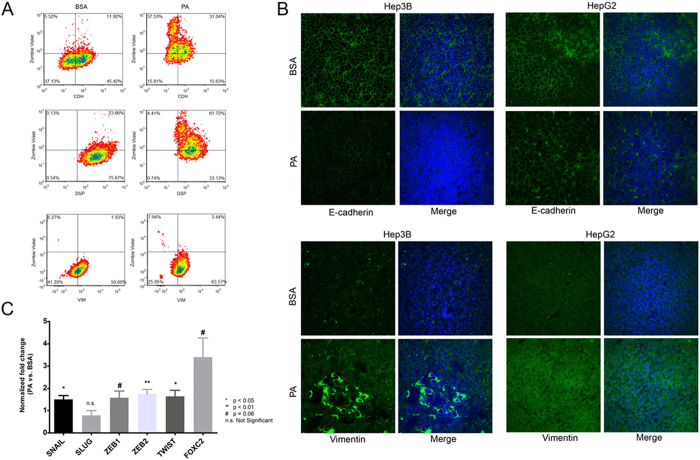
Population effect of PA on EMT marker expression.(A) Density plots showing distribution of cells co-stained with zombie violet (Y-axis) and either CDH, DSP or VIM (X-axis) in HepG2 cells treated with BSA or PA (0.3 mM). The bars represent staining thresholds for zombie violet (horizontal bar) or the protein markers (vertical bar). Lower left quadrant represents background staining, upper left quadrant represents cells stained with only zombie violet, upper right quadrant represent cells co-stained with zombie violet and protein marker and lower right quadrant represent cells stained with protein marker only. The numbers in the plot represent the percentage of total cells within that quadrant. (B) Confocal images showing specific regions with altered expression levels of CDH and VIM in HepG2 and Hep3B cells. Blue indicates nuclear staining and green indicates CDH or VIM staining. Images were recorded at 40× with identical exposure and PMT settings maintained between BSA and PA treated cells for a given marker (scale bar = 100 μm). C Bar graph showing fold-change in mRNA expression levels of various EMT transcription factors determined by qRT-PCR in PA (0.3 mM) treated HepG2 cells compared to corresponding expression levels in BSA treated cells (GAPDH normalized). P-values indicate significance levels compared to BSA determined by Student’s t-test (two tailed), n = 3.